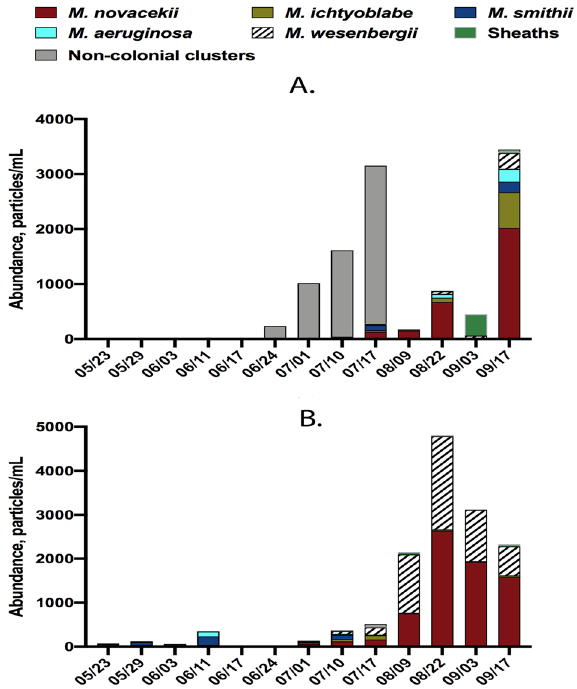
Figure 4. Seasonal changes of abundances of Microcystis spp. colonial morphoforms and water temperature from May to September 2019 in mesocosm tanks D1 ( A ) and G1 ( B